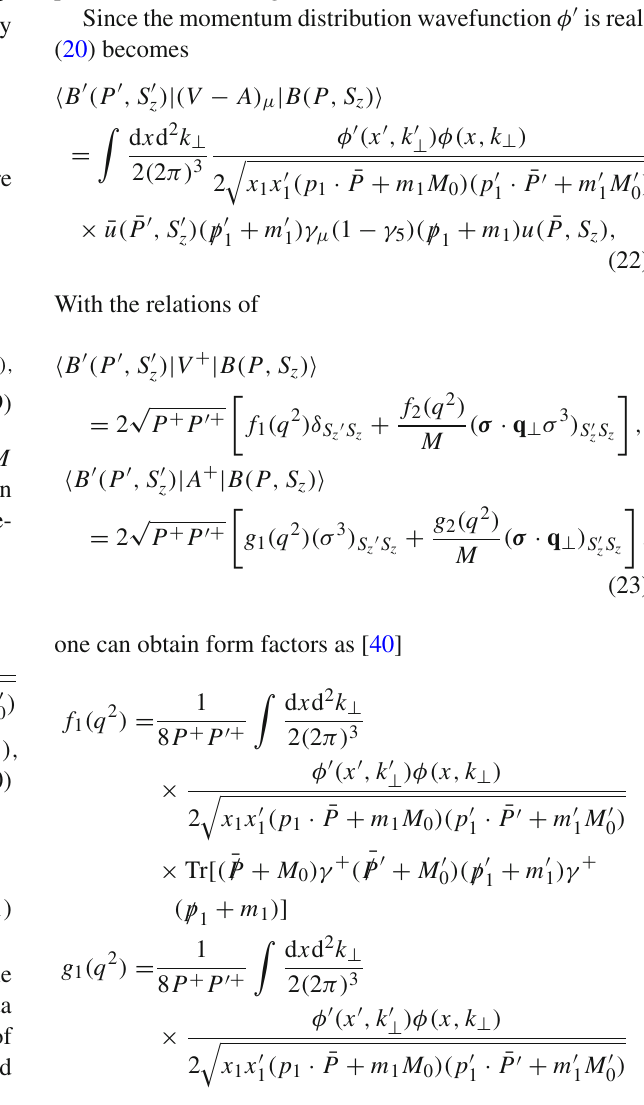
Fig. 2 Feynmandiagramsforbaryon–baryontransitionsinthediquark picture. P ( (cid:2) ) is the momentum of the incoming (outgoing) baryon, p is the quark momentum, p 2 is the diquark momentum and the cross mark denotes the corresponding vertex of weak interaction ¯ ¯ + p P = p 1 + p 2 and P (cid:2) = p (cid:2) as 2 , respectively. The Feyn- 1 man diagram of the baryon–baryon transitions in the